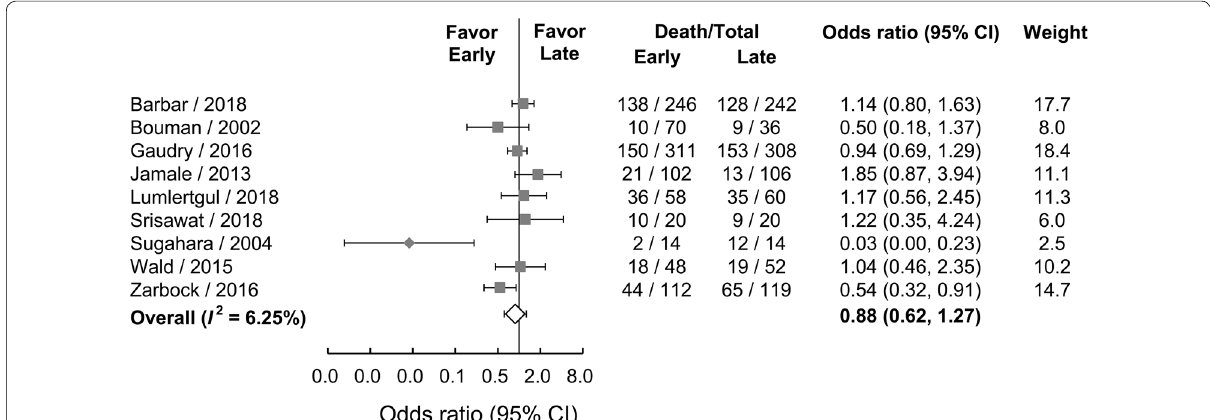
Fig. 3 Forest plot for comparison of mortality between the early and late renal replacement therapy initiation groups in the included randomized controlled trials